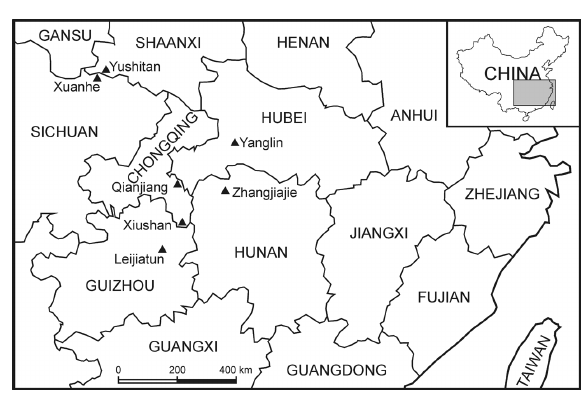
Fig. 1. Locations of the studied sections. Black triangles indicate the positions of the studied sections.